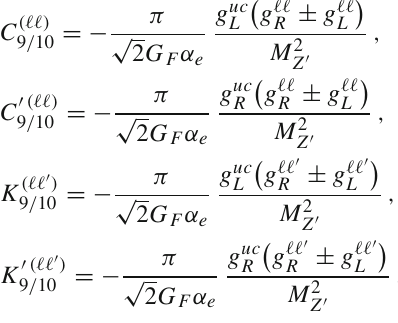
case of only one non-zero coupling present ( g L (cid:15)= 0 and g R = 0 or g R (cid:15)= 0 and g L = 0), constraints are severe, | (cid:2) 8 × 10 − 4 ( M / TeV ) ; assuming order one muon | g L / R Z (cid:3) son coefficients read C 9 / 10 (cid:2) O ( 10 − 2 ) for M Z (cid:3) (cid:3) 1